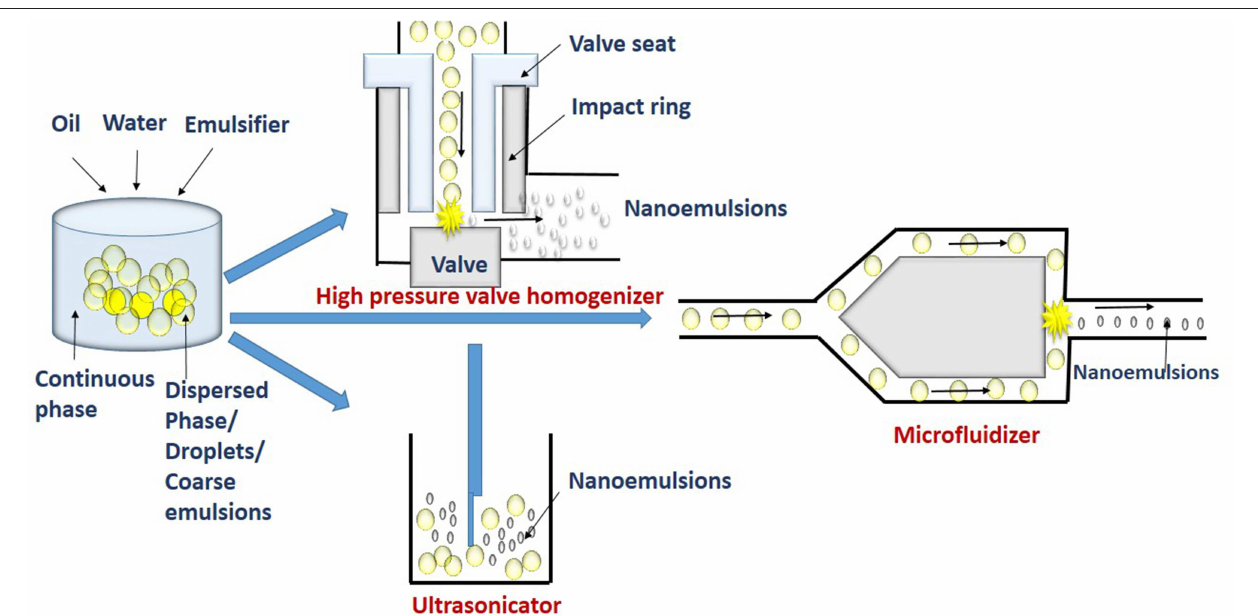
FIGURE 2 | High energy methods such as high pressure homogenization (HPH), microfluidizer, and ultrasonication break macroemulsions into smaller